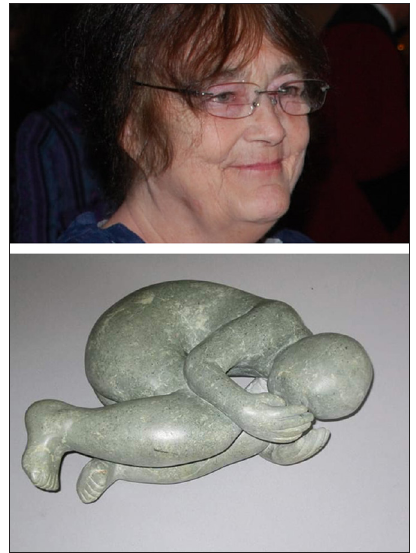
Figure 4: Jane Hubert and one of her sculptures used in her teaching practice (Photo: Jane